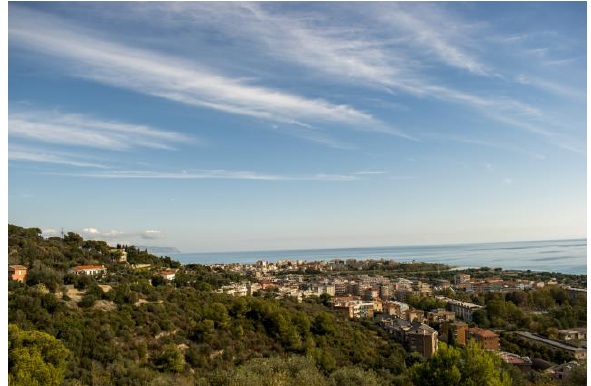
Figure 6. The cultural landscape of Albenga